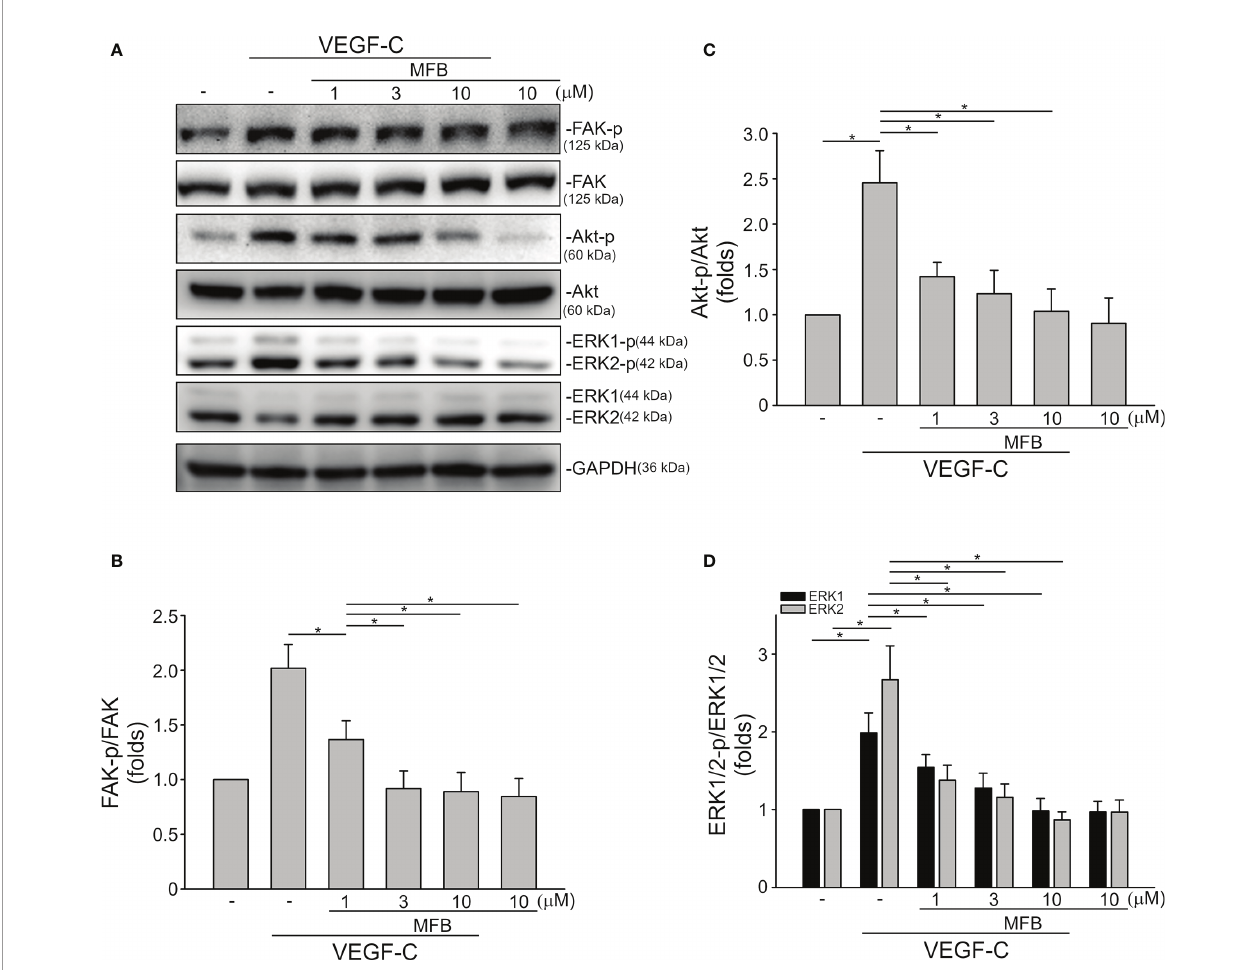
FIGURE 5 | MFB reduced FAK, Akt, and ERK1/2 phosphorylation in VEGF-C-stimulated SV-LECs. (A) SV-LECs were treated with MFB for 30 min, followed by the stimulation with VEGF-C (100 ng/ml) for another 30 min. The effects of MFB on the phosphorylation of FAK, Akt, and ERK1/2 were determined by immunoblotting.